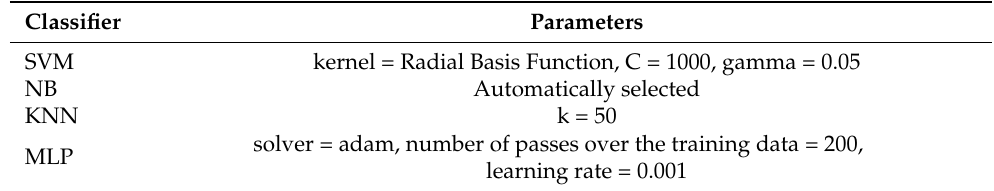
Table 1. Classifier